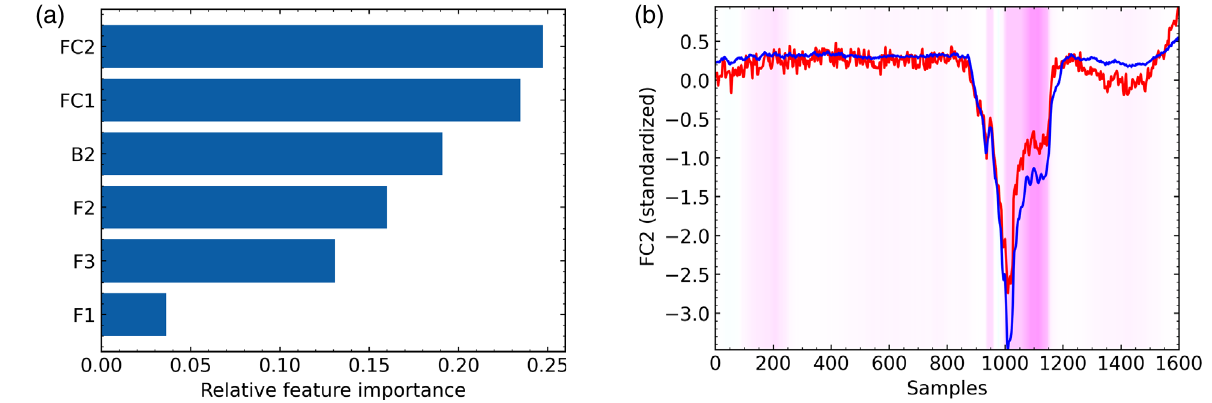
FIG. 15. Most important signals (a) and FC2 samples (b) for predicting follow-up breakdowns with event data. In addition to the most important samples (marked by the pink background), the average preceding signal for a subsequent healthy event (blue) and a breakdown event (red) is shown,